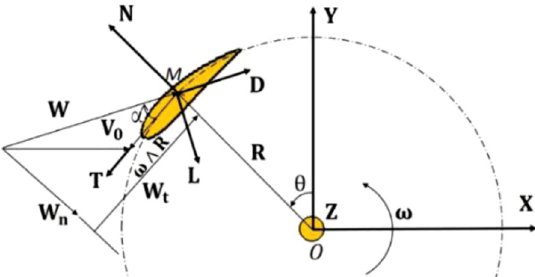
Fig. 2. Transversal cross section of a HARVEST rotor displaying a single blade and the turbine hub. The fl ow is oriented from left to